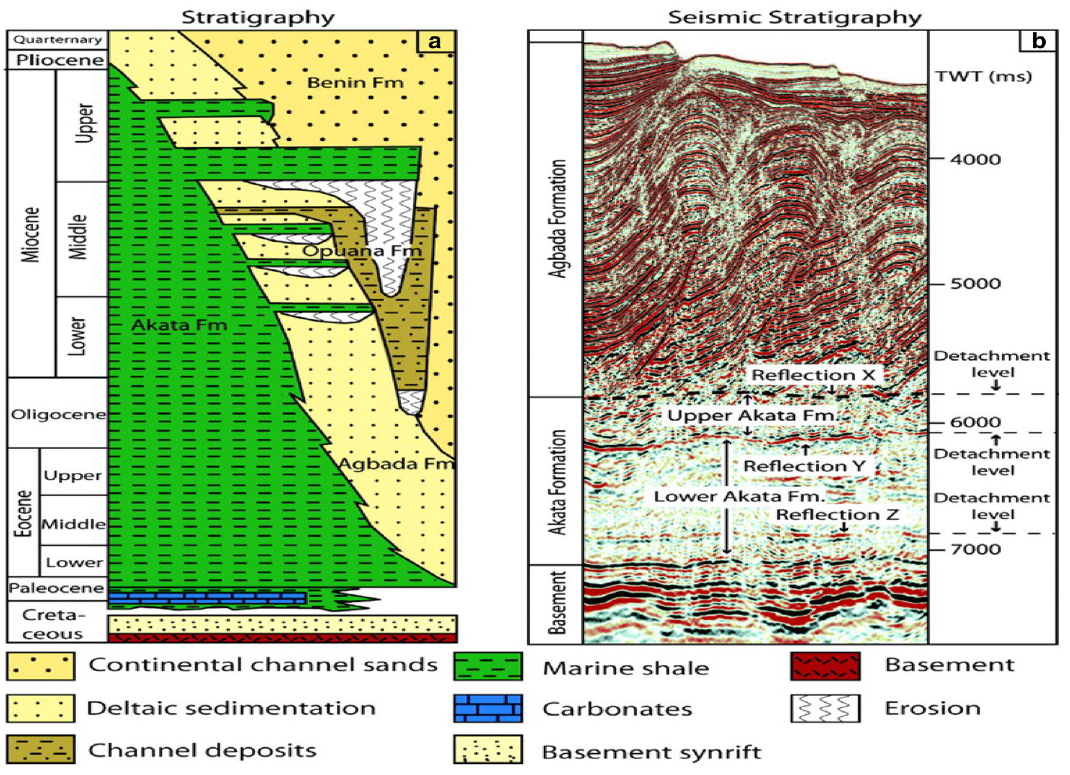
Fig. 3 Stratigraphy of the Niger Delta. (Doust and Omatsola